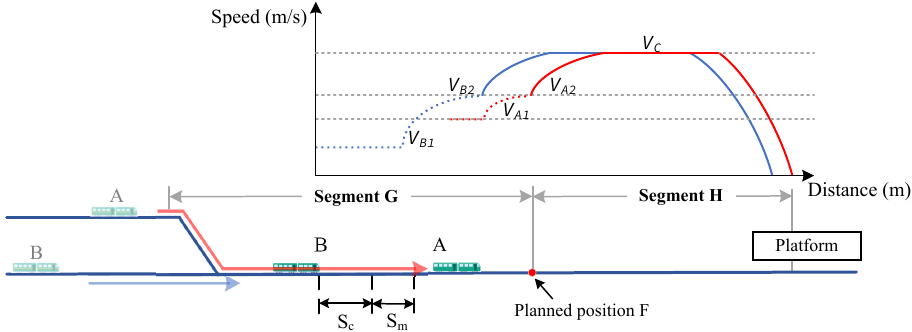
Figure 1. Coupling and coupled states of train A and train